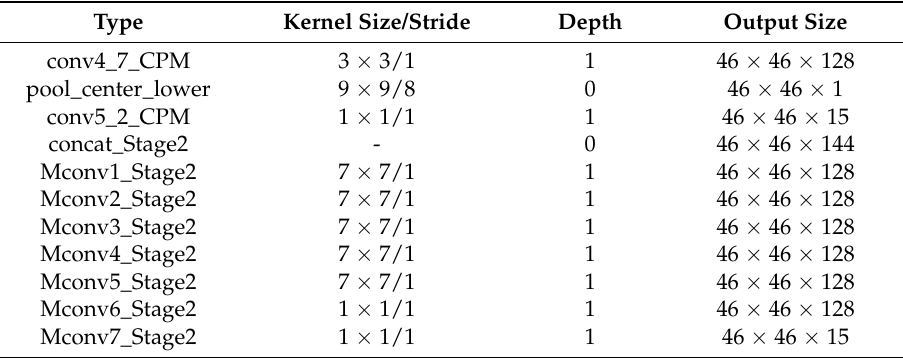
Table 2. The main data change of the stage ≥ 2